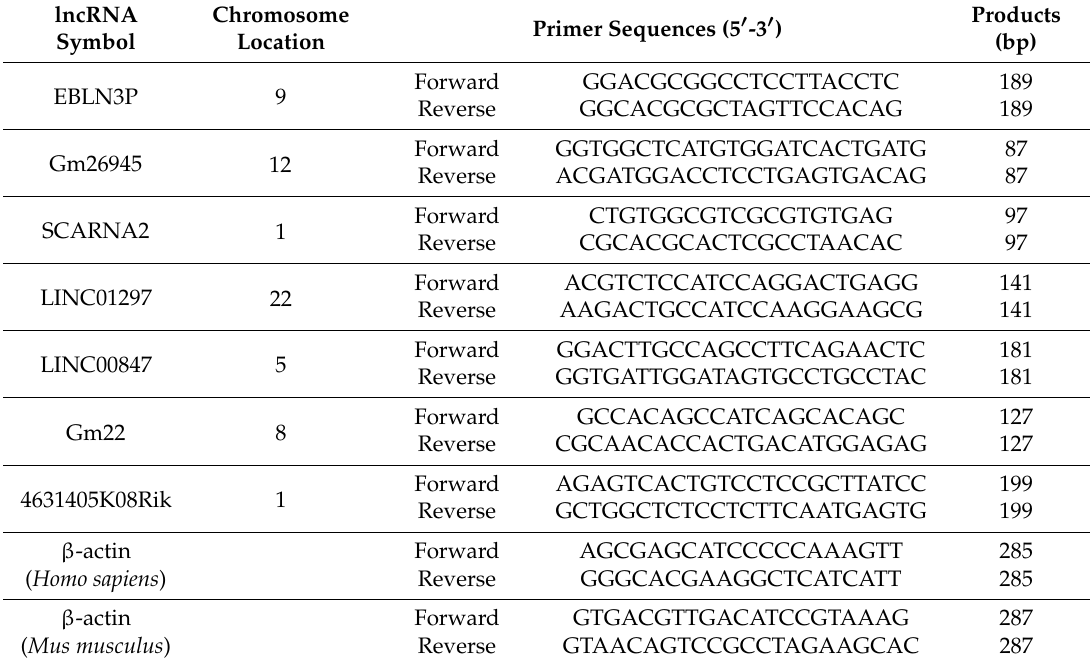
Table 1. Primers used for